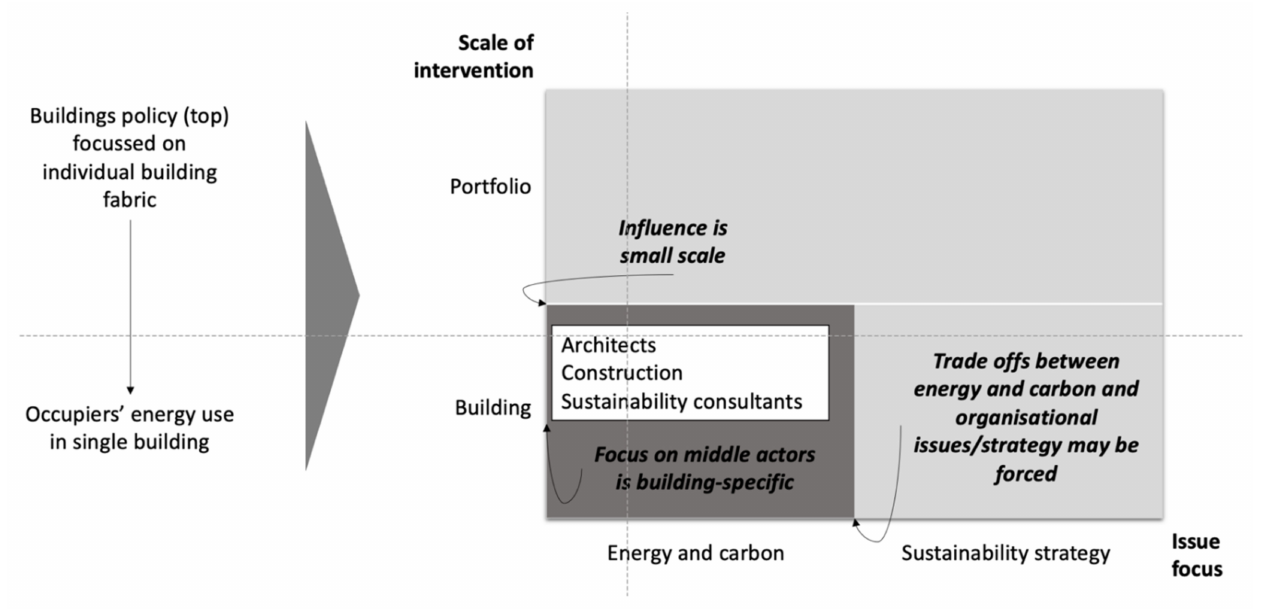
Figure 2. Policy focused on individual building and its fabric.